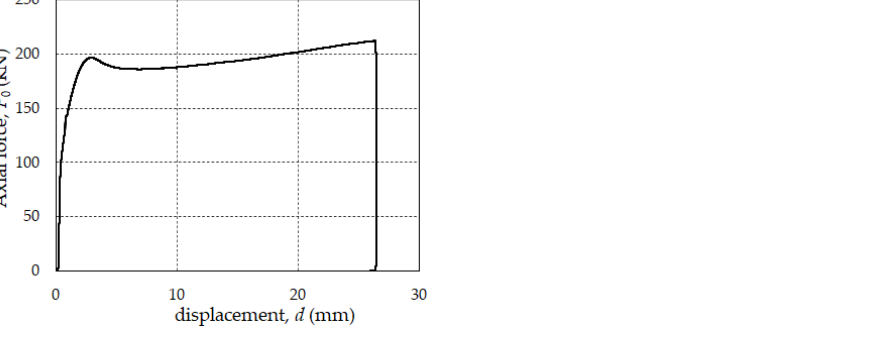
Figure 9. Ramp test of the PS-LED prototype subjected to deformation increasing to the amplified seismic deflection γ x γ b d bd .